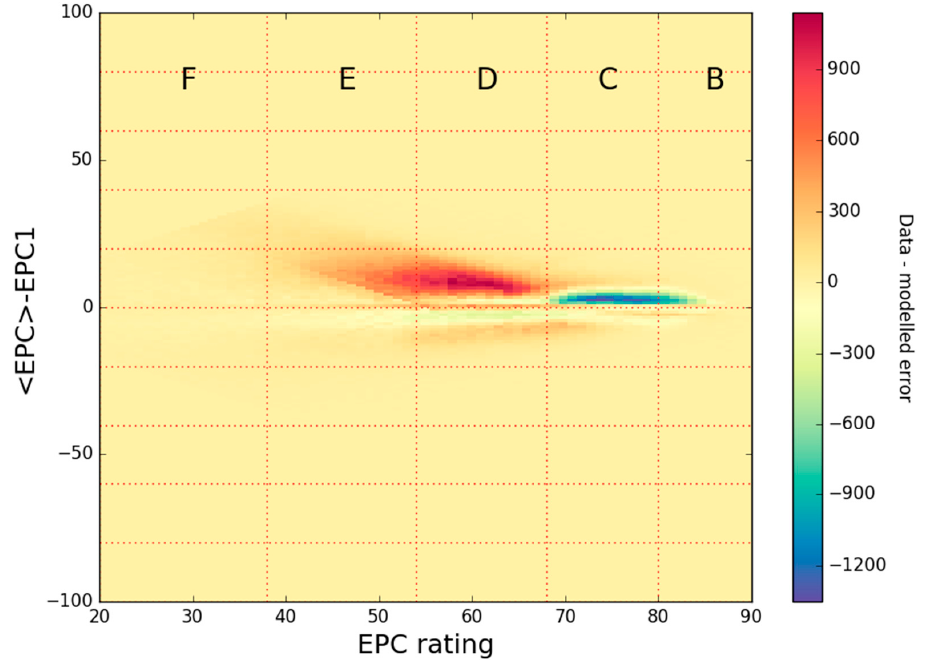
Figure 10. Data minus modelled error, highlighting areas in which the semiparametric error model does not predict the data well. Regions in which there is more data than the error model predicts are shown in red, regions in which there is less data than the model predicts are shown in blue.